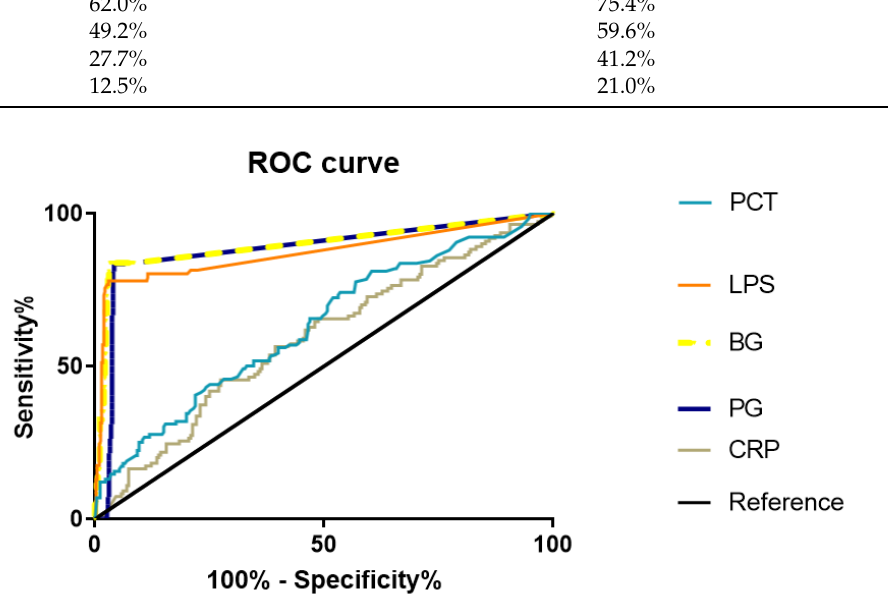
Figure 1. Receiver operating characteristic (ROC) curve analyses of the PGN, LPS, BDG, CRP, and PCT assays for the diagnosis of BSI (the diagnostic standard: blood culture combined with clinical diagnosis). Table 6. Efficacy evaluation of GN, LPS, BDG, CRP, and PCT in the diagnosis of BSI.